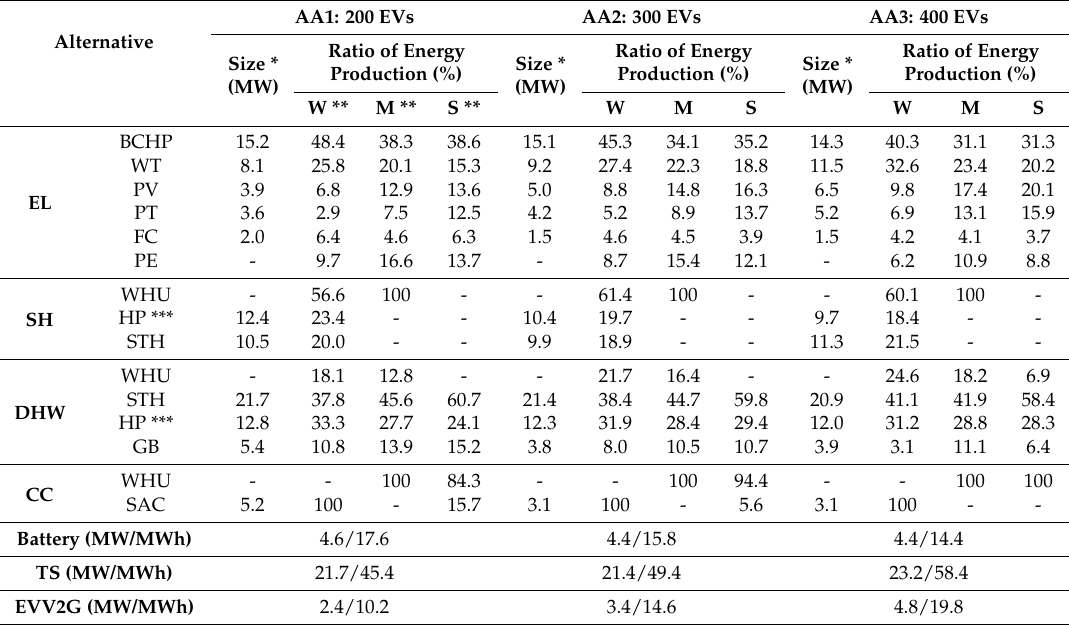
Table 9. Optimal MENR system scenarios with increasing scale of EVs in Xizhou